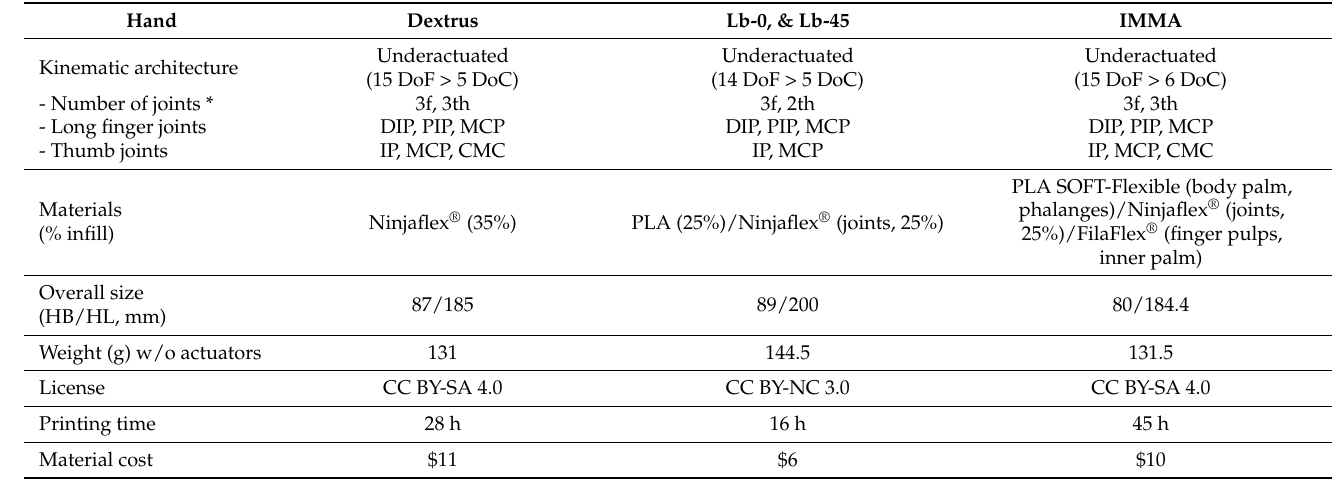
Table 1. Main design characteristics of the selected affordable hands used for the present